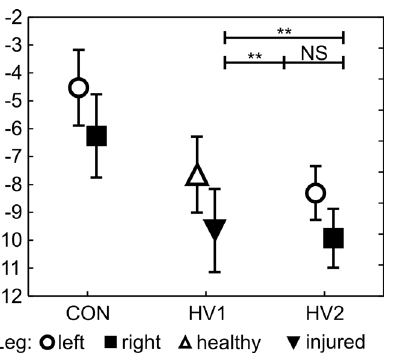
Fig.7 Peak ankle plantar flexion (in deg) at loading response phase